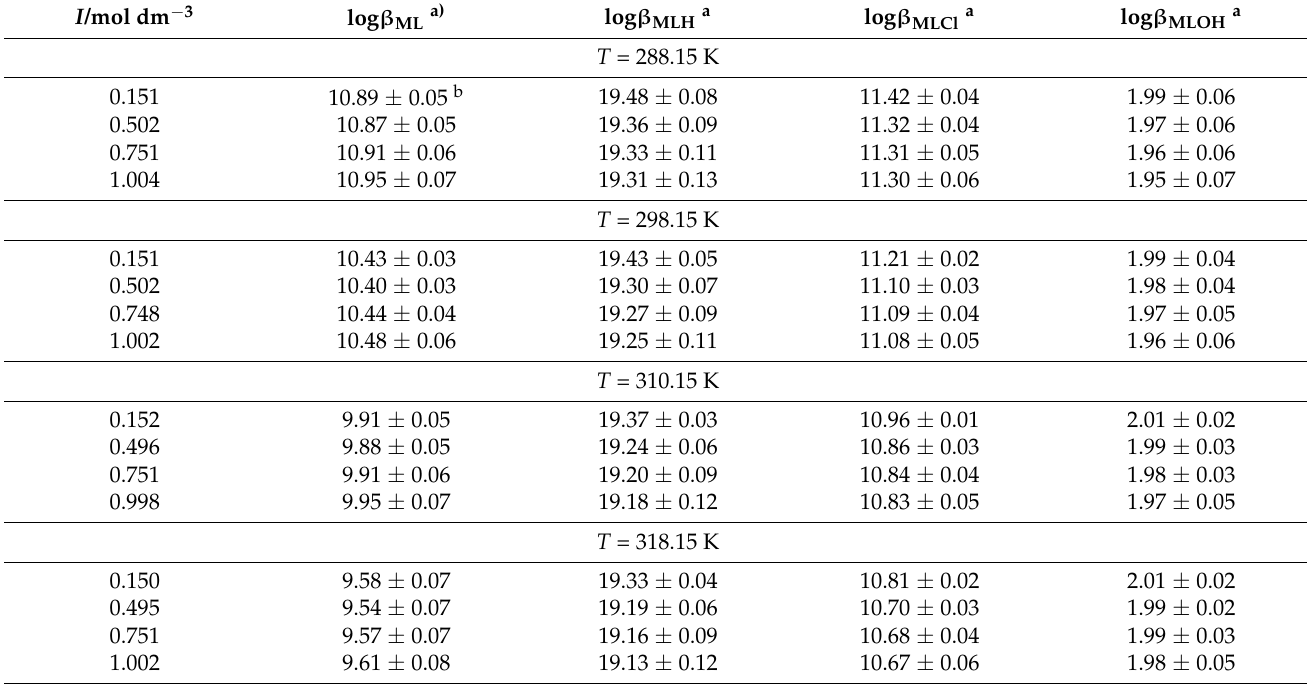
Table 3. Experimental formation constants of the CH 3 Hg + /Dop − species in NaCl aqueous solutions at different ionic strengths and temperatures.